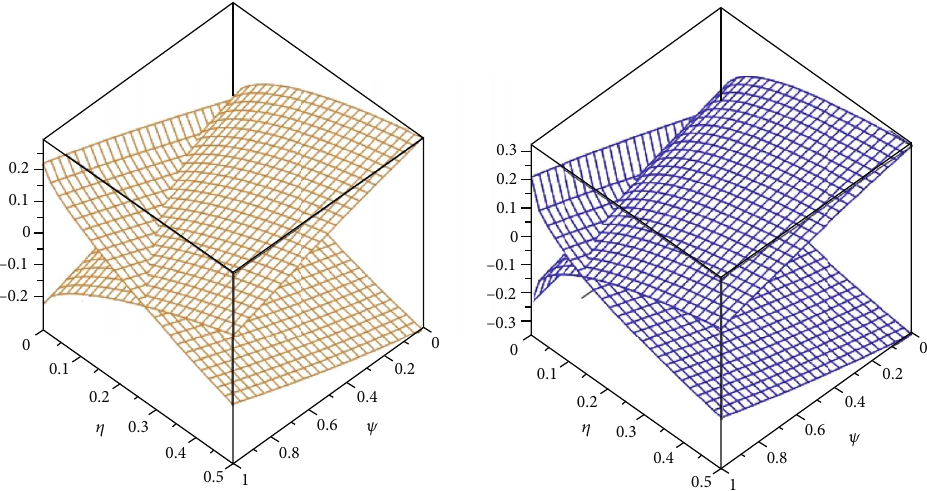
Figure 10: The fi rst graph shows the fuzzy 3D upper and lower fi gure of analytical solution at γ = 0 : 6 and the second graph at fractional of γ = 0 : 4